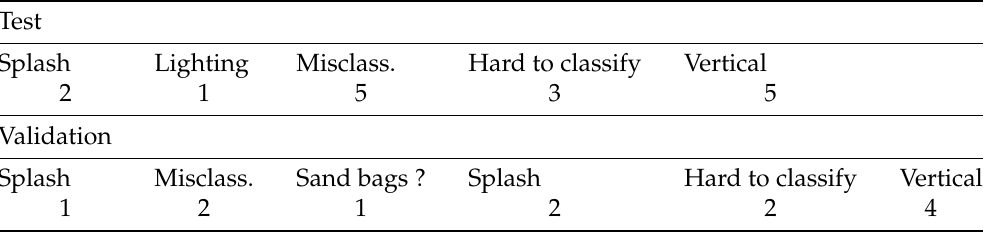
Table A5. Errors explanation for Biarritz data. “Misclass.” stands for misclassification during annotation, “Splash” corresponds to an intermediate storm regime between impact and overwash, “Vertical” corresponds to the presences of vertical features of runup.